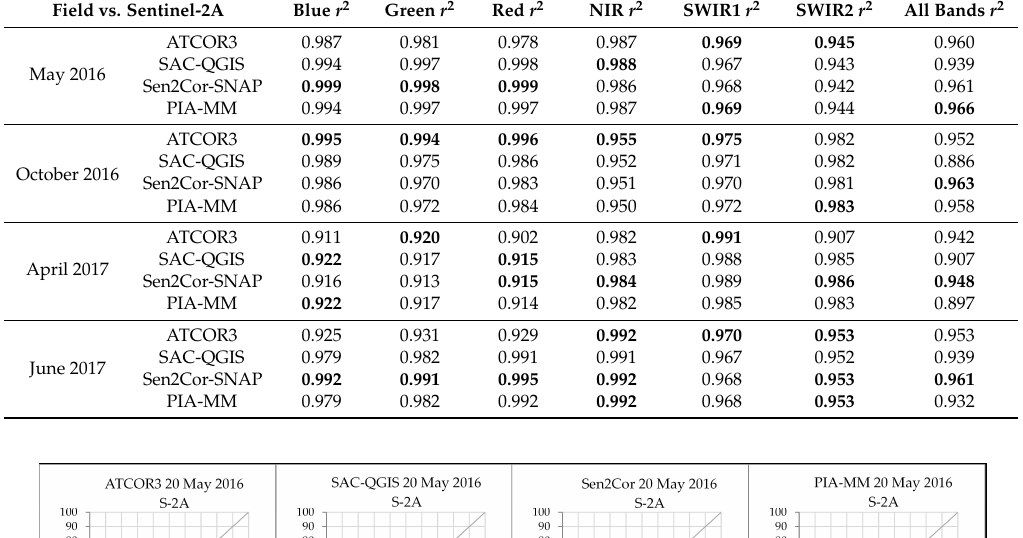
Table 6. Overall, band-by-band RMSE between field spectroradiometry values and atmospheric corrections for Sentinel-2A (MSI) imagery (% reflectance units) grouping all dates. Best values in bold.